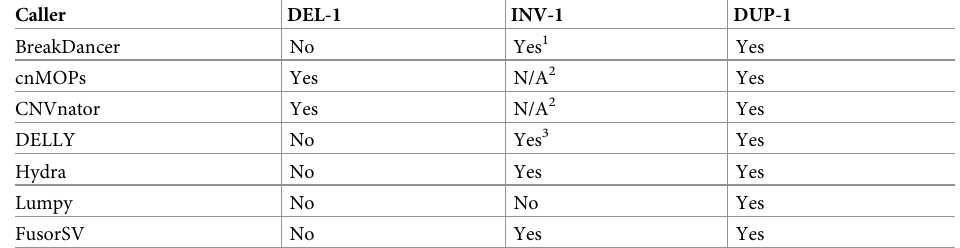
Structural variation prediction using simulated long-read data Simulated PacBio DNA sequencing data was used to evaluate using long-read sequencing to validate SV calls generated from short-read sequencing platforms. The mock genomes con- taining simulated deletions, tandem duplications, and inversions were used to generate simu- lated PacBio reads at 5X, 15X, 30X, 60X, and 142X depth of coverage. Table 2. Identification of known variants in C . elegans